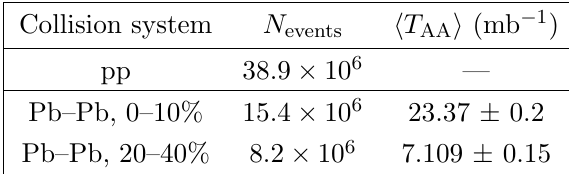
Table 1 . Number of events for the pp collisions and the two Pb{Pb centrality classes after applying the event selection. In the right column the average nuclear overlap function is reported for the Pb{Pb samples